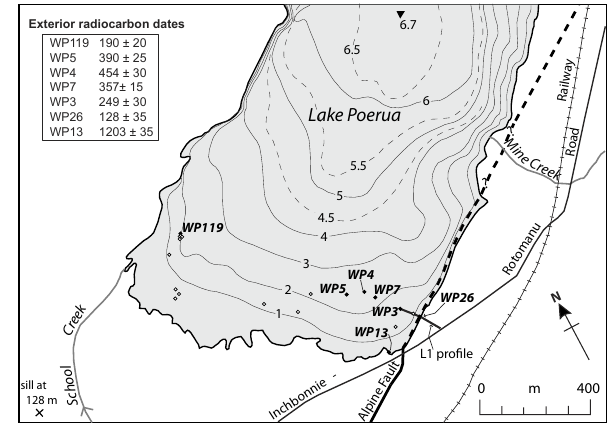
Fig. 7. Bathymetric map of the southern half of Lake Poerua, with contours every 0.5–1m (after Irwin, 1982). GPS surveyed tree stumps are shown by filled (radiocarbon dated) and unfilled circles. Exterior radiocarbon dates for these stumps are indicated at top left. Traces of the Alpine Fault are shown on land and dashed along the southeastern shore of the lake and beneath the Mine Creek fan where concealed. Bold line (L1 profile) represents the topographic- bathymetric profile shown in Fig. 8.